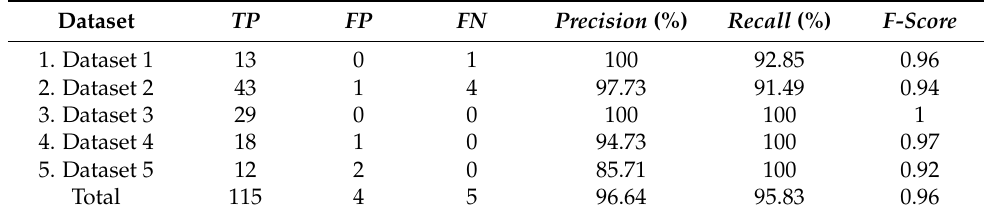
Table 4. Accuracy evaluation of trunk extraction